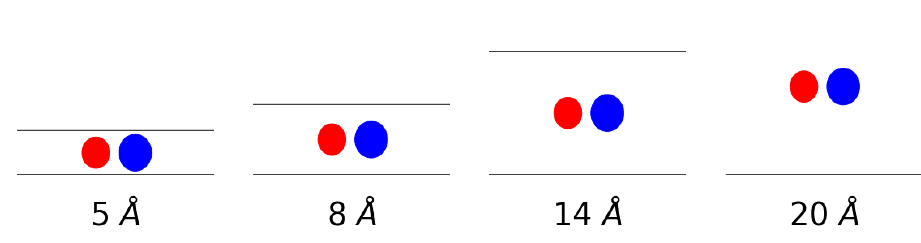
Figure 1. A schematic representation of the gas molecules within the considered pores. The spheres represent the van der Waals radii of methane (blue) and hydrogen (red) and the black lines represent the graphene